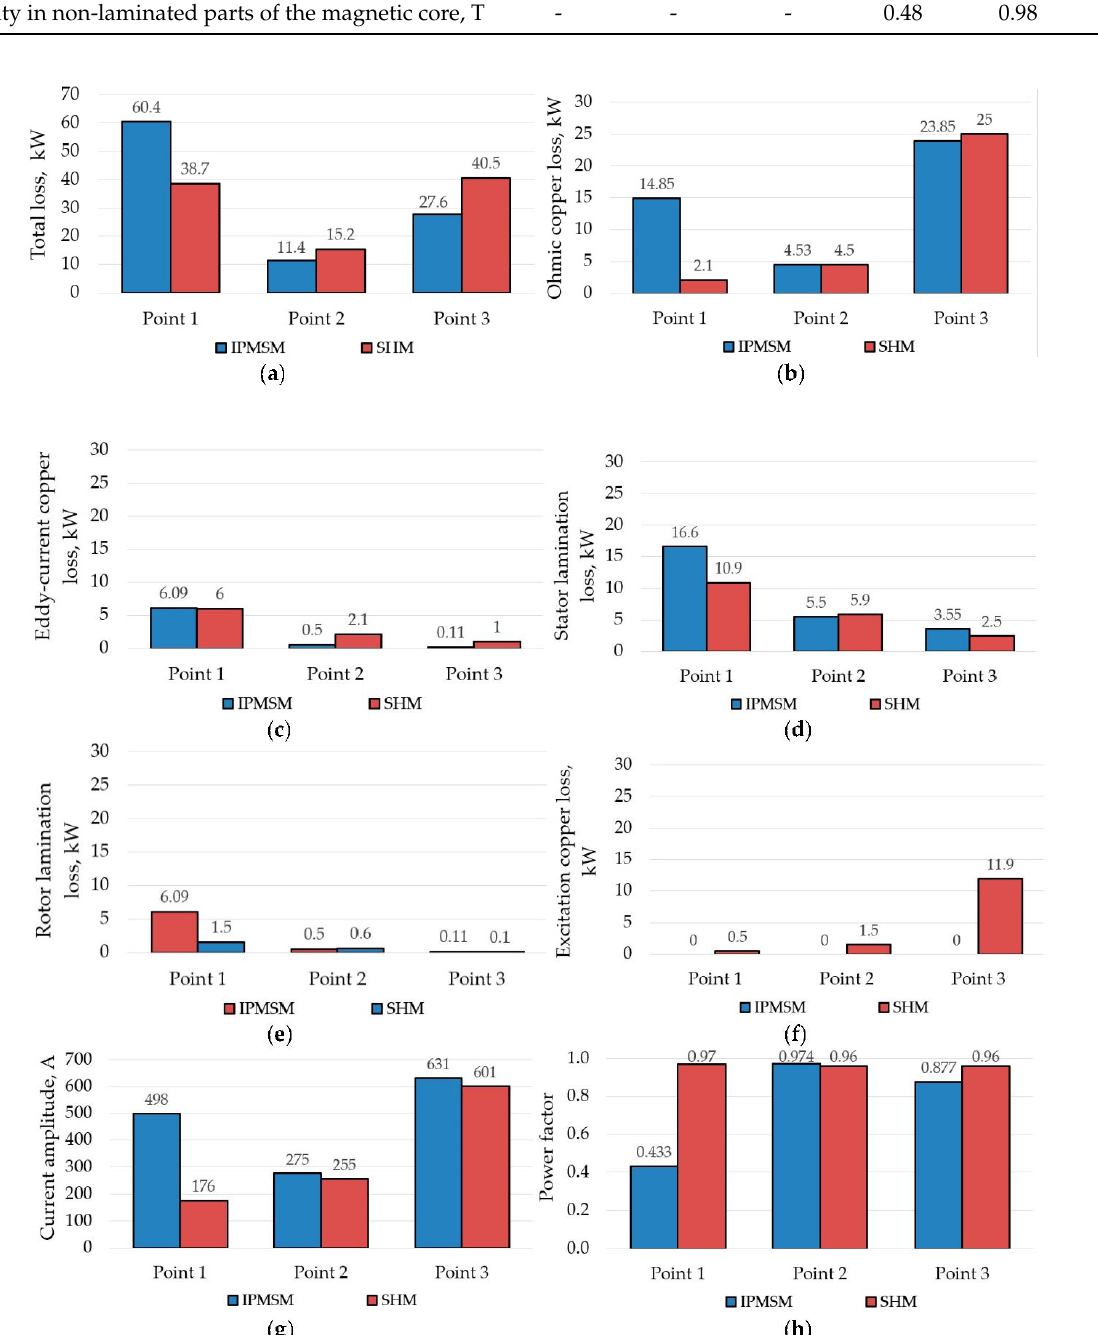
Figure 8. Performance comparison of IPMSM and SHM after the optimization for different operating points: ( a ) total loss; ( b ) armature ohmic copper loss; ( c ) armature eddy-current copper loss; ( d ) stator lamination loss; ( e ) rotor lamination loss; ( f ) excitation copper loss, kW; ( g ) amplitude of the armature phase current; ( h ) power factor.